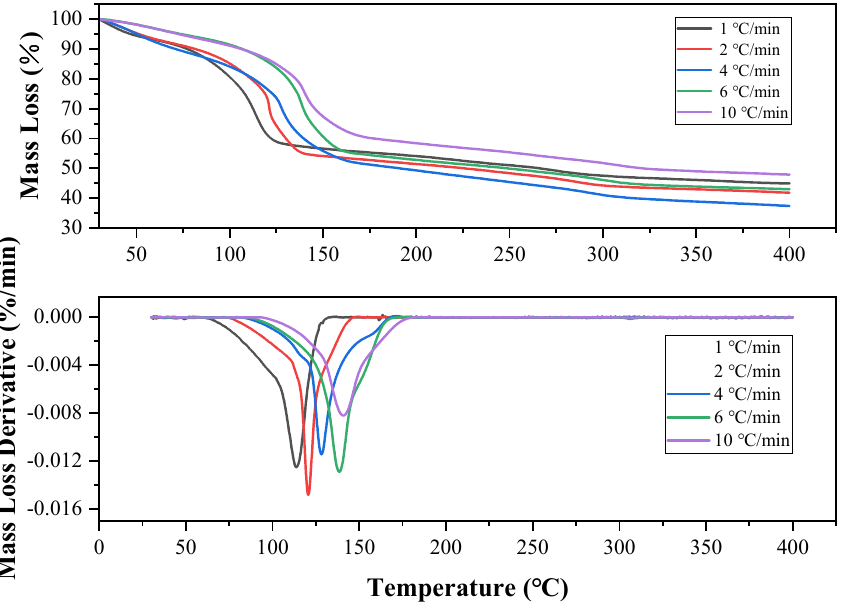
Figure 7. TG-DTG curve of lithiated anode with BL electrolyte at different β . The E a values of mixtures of different electrolytes and lithiated anode powders were calculated at five heating rates ( β = 1.0, 2.0, 4.0, 6.0, and 10 ◦ C/min), and 12 various α values were used for differential isoconversional analysis. Figure 8 shows the fitting results for different α values under the three kinetic models. In addition, the fitting results calculated by the KAS model are given in Figure 8, and the trends in the fitted lines for different α values tended to be consistent. This phenomenon also existed in the FWO and